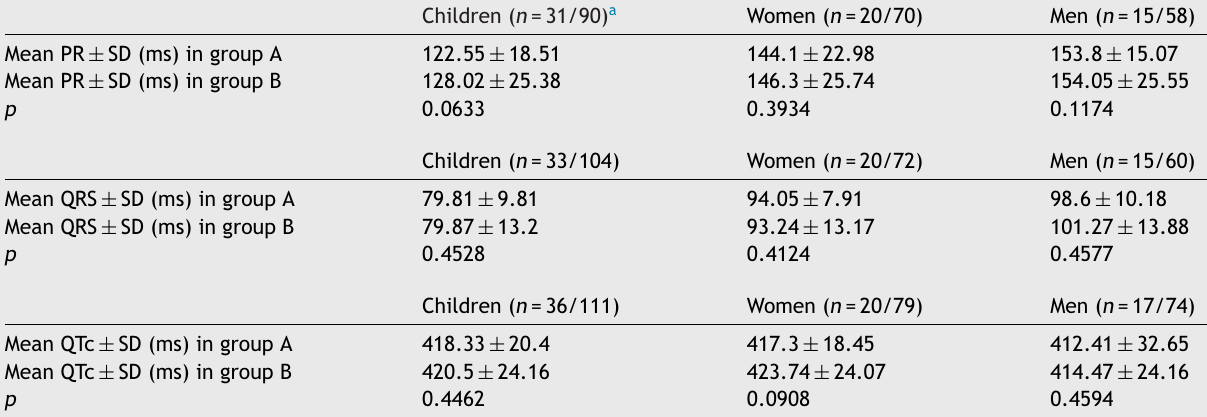
Findings of PR interval, QRS complex, and QTc interval in 2 groups. Group A, patients with homozygous genotype c.[35delG];[(35delG)] and heterozygous genotype [GJB2:c.35delG];[GJB6:del(GJB6-D13S1830)]; group B, all other patients (with other heterozygous genotype and without any mutation in